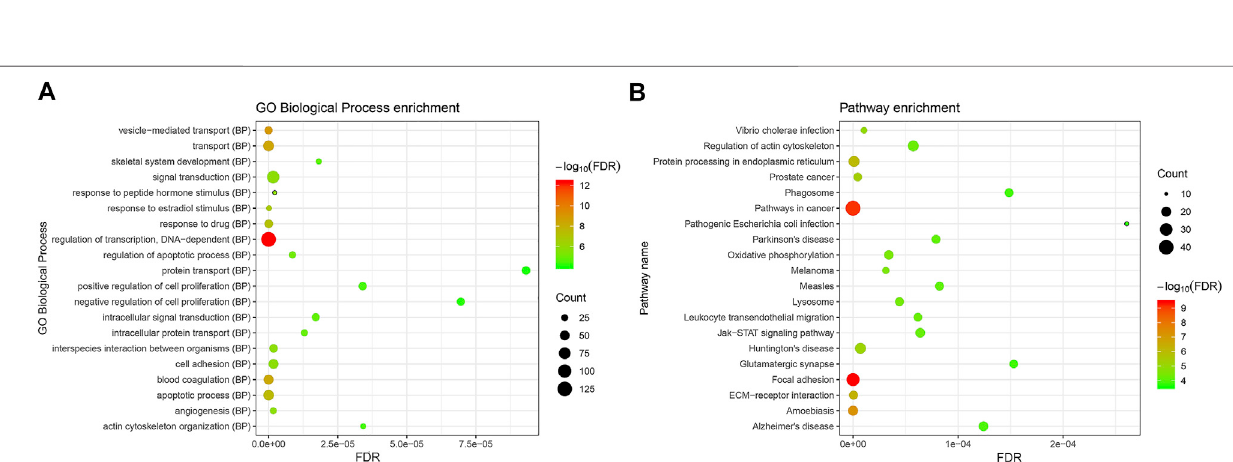
FIGURE 2 | DEMis-targeted DEMs network in IDD. (A) Network among down-regulated DEMis and up-regulated DEMs; (B) network among up-regulated DEMis and down-regulated DEMs; green and purple node indicated down-regulated DEMis and up-regulated DEMis, respectively, and red and turquoise node indicated up- regulated DEMs and down-regulated DEMs, respectively. DEMis: differentially expressed microRNAs; DEMs: differentially expressed mRNAs; and IDD: intervertebral disc degeneration.